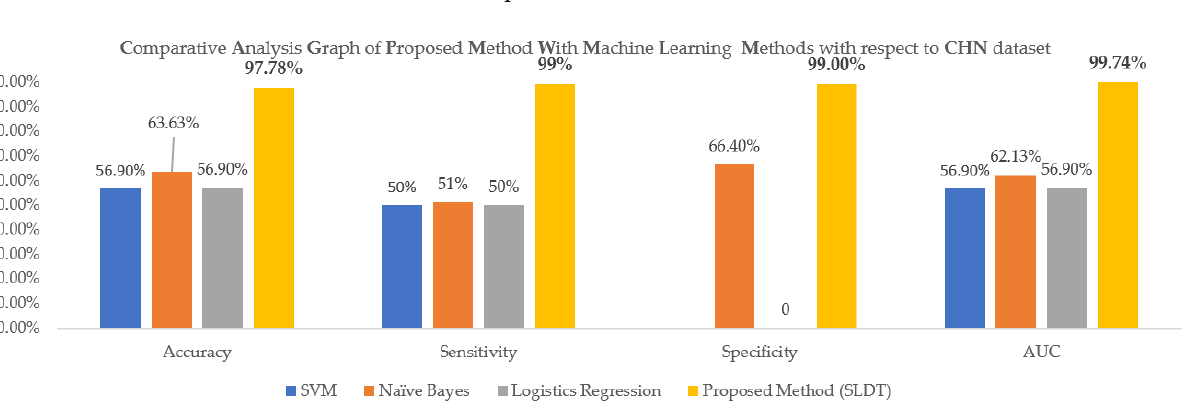
Figure 12. Comparative analysis graph of the proposed method with the machine learning methods with respect to the MC dataset.